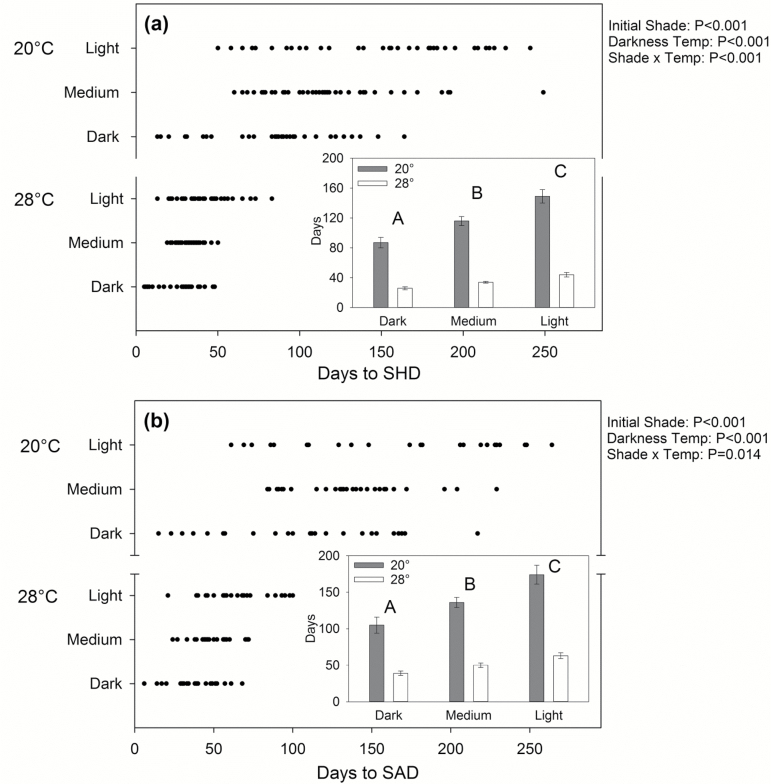
Darkness-temperature and initial (pre-darkness) shade treatment effects on survival time under darkness treatment. The number of days from the onset of darkness until (a) half the stem was dead (SHD) and (b) the whole stem was dead (SAD). Significant effects from permutation-based ANOVA are shown. Points represent individual seedling values. Inset graphs show treatment means ± SE, with different letters indicating significant differences between initial shade treatments across both darkness temperatures (i.e. main shade treatment effect) according to Tukey’s HSD. For sample sizes, see Supplementary Table S3.